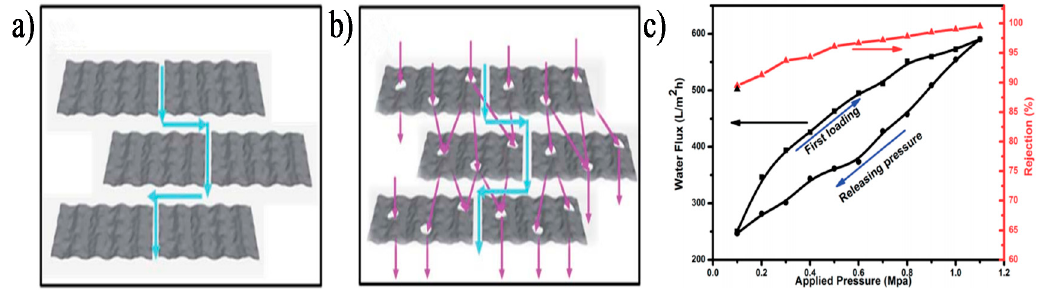
Figure 8. Schematic diagrams of transport path of ( a ) original GO; ( b ) mesoporous GO membrane; ( c ) the separation property of mesoporous GO membrane [114]. Copyright 2014 Royal Society of Chemistry.